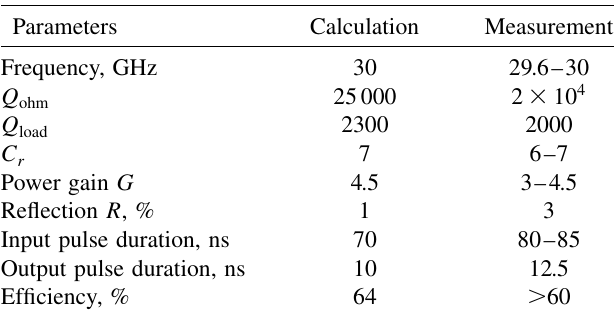
TABLE II. Parameters of the tested 30 GHz OC SLED-II